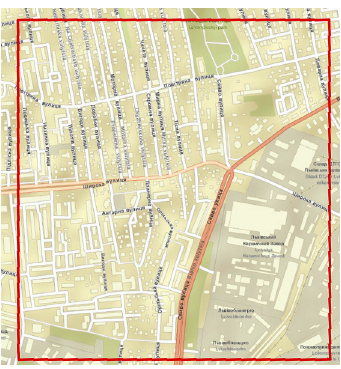
Figure 1. Building clutter height with one height value for one building feature